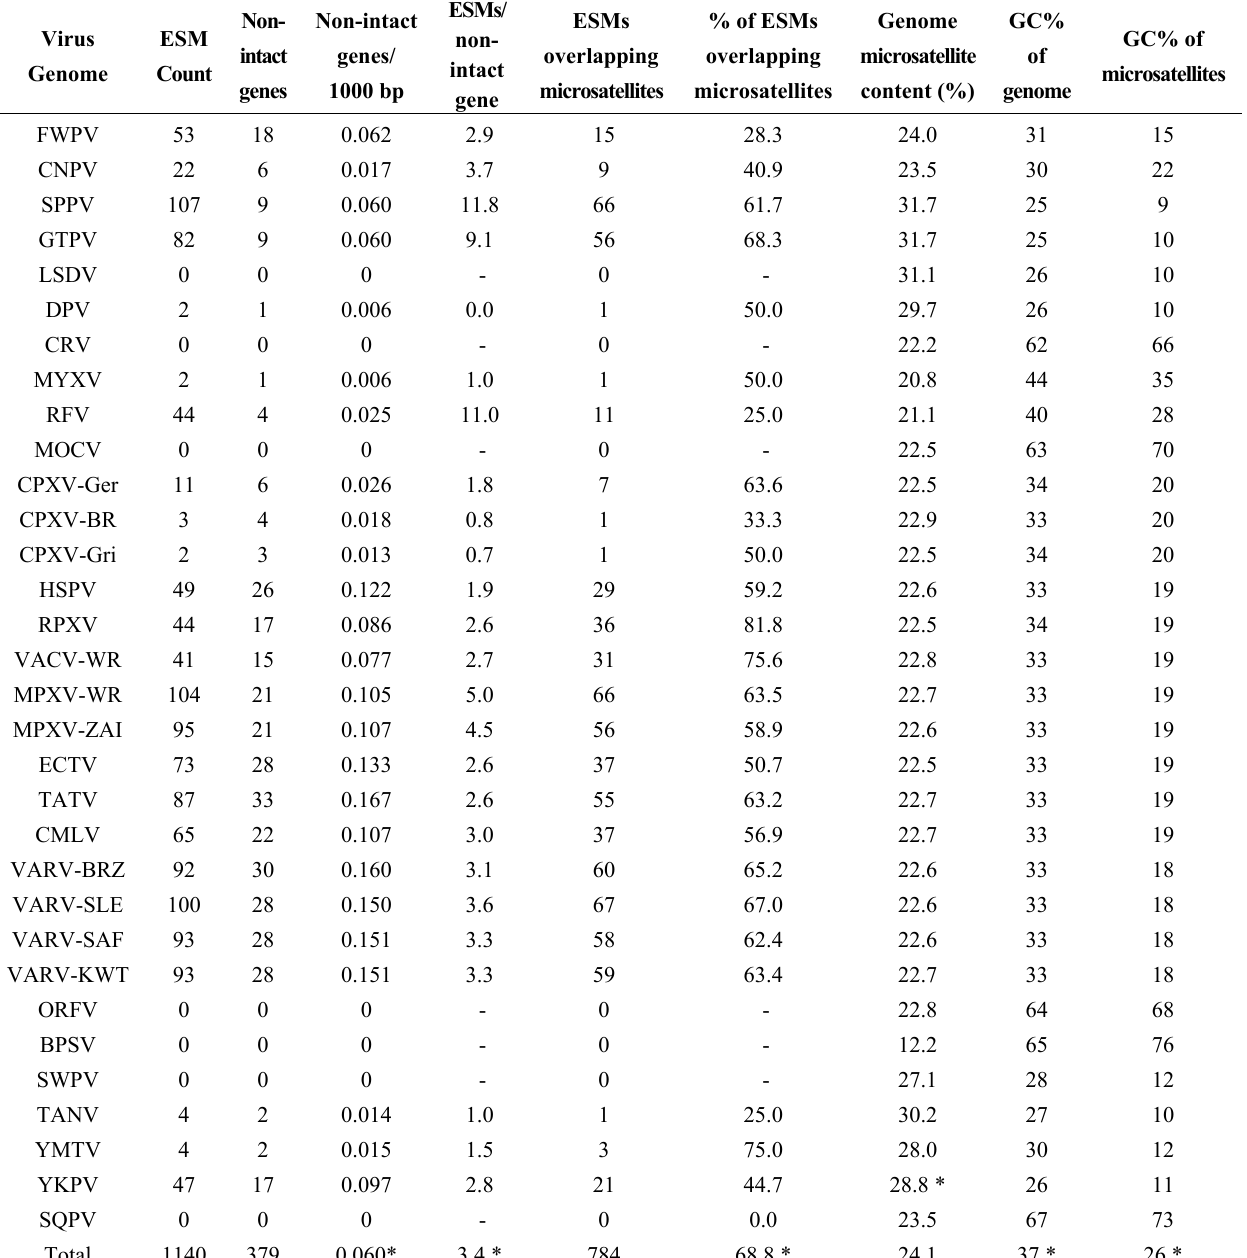
Table 2. Comparative genomic content of early stop mutationss and microsatellites. Virus